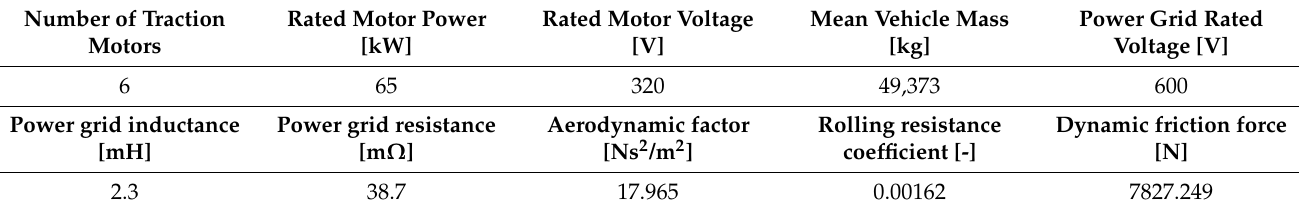
Table 2. Parameters of tram vehicle TMK 2200_K and power grid.